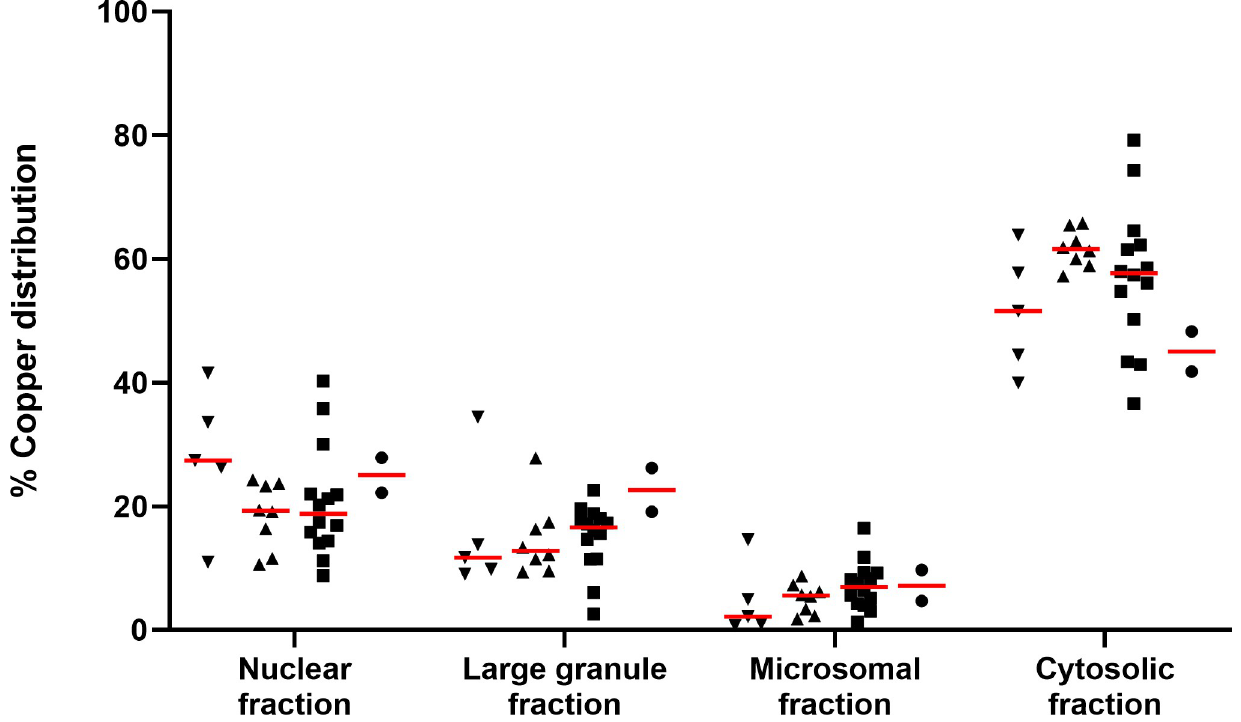
Fig 1. The intracellular distribution of copper in liver specimens from cats. ( ▼ ) specimens with copper concentrations < 100 μ g/g dry weight (Group 1; n = 5), ( ▲ ) specimens with copper concentrations 100–180 μ g/g dry weight (Group 2; n = 8), ( ■ ) specimens with copper concentrations 181–700 μ g/g dry weight (Group 3; n = 14), ( ● ) specimens with copper concentrations > 700 μ g/g dry weight (Group 4; n = 2). In all 4 groups, copper was found most abundantly in the cytosolic fraction, followed by the nuclear, large granule, and microsomal fractions, respectively. The red lines represent the